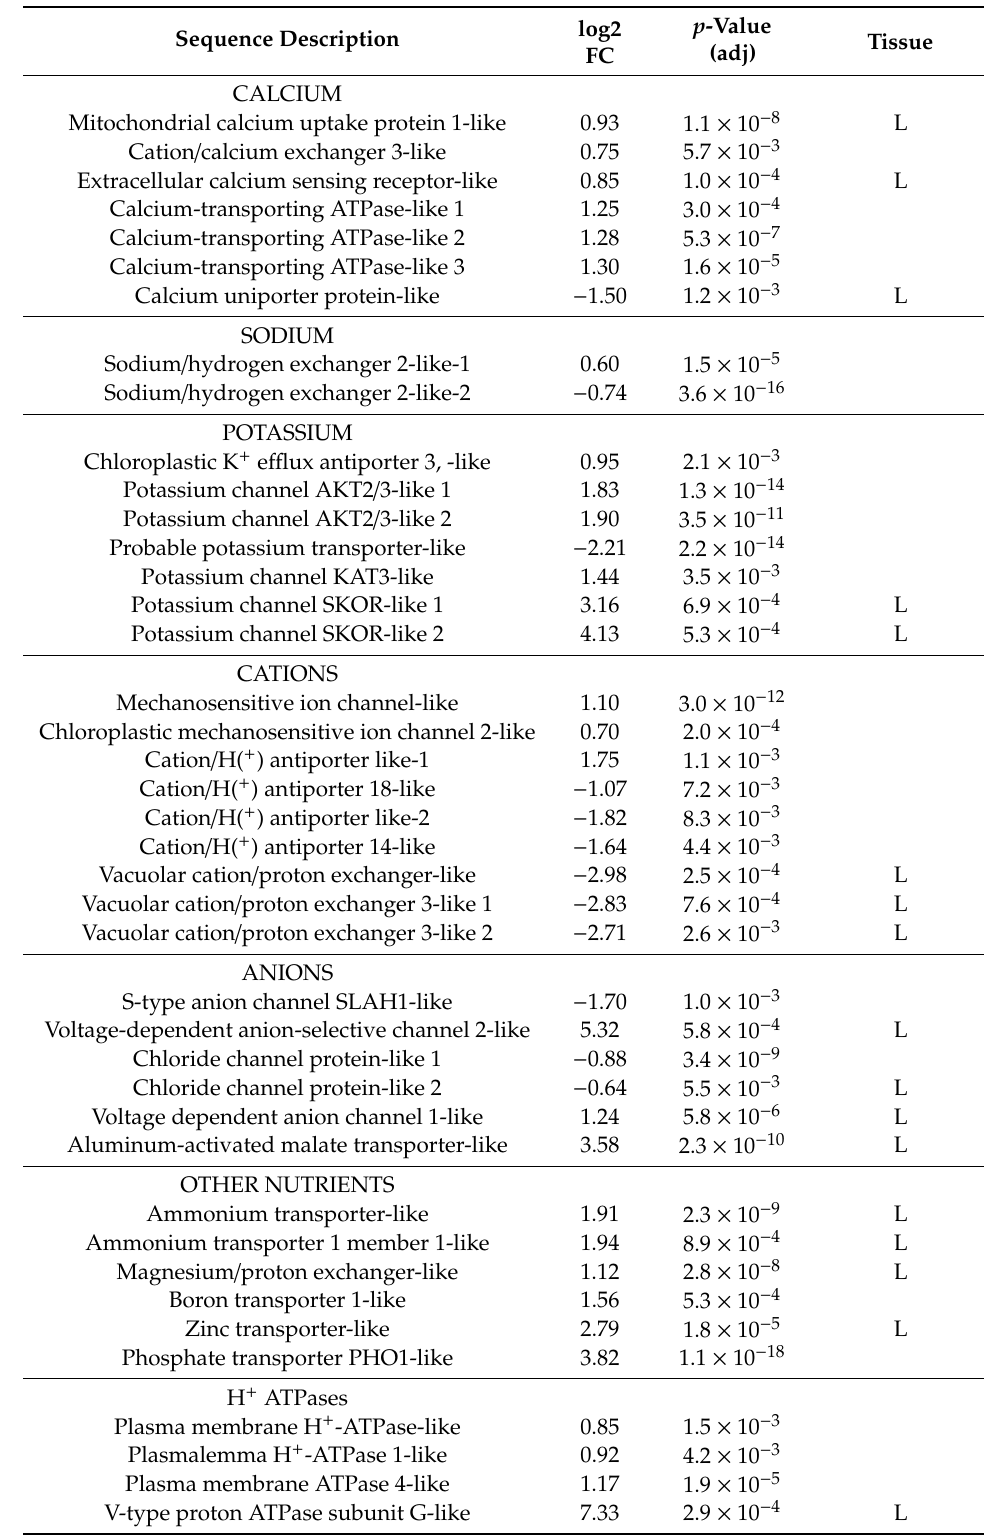
Table 3. Di ff erentially expressed genes related to ion uptake and accumulation in tolerant vs. sensitive plants. Tissue column indicates tissue specificity of the tolerant vs. sensitive